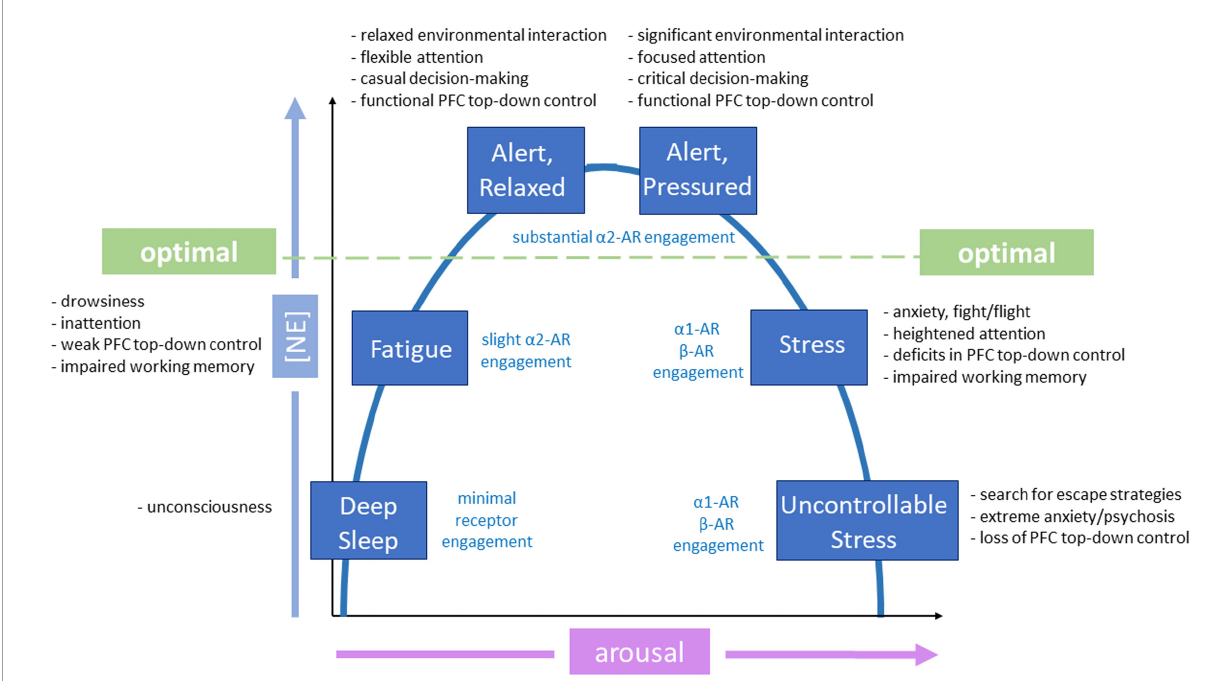
FIGURE4 Inverted-U functionality of different adrenergic receptors in behaviors. Inverted-U model of norepinephrine (NE) modulation relates to activation of various levels and types of adrenergic receptors and phenotypes. Different adrenergic receptors are activated depending on level of arousal. The green dotted line indicates the threshold for optimal prefrontal functioning, influenced by substantial α 2-adrenergic receptor (AR) engagement. Phenotypic manifestations associated with each state and level of NE release are also provided. Modified from Cools and Arnsten